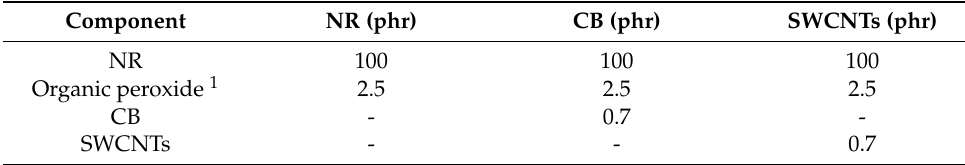
Table 3. Formulations used for organic peroxide vulcanized NR